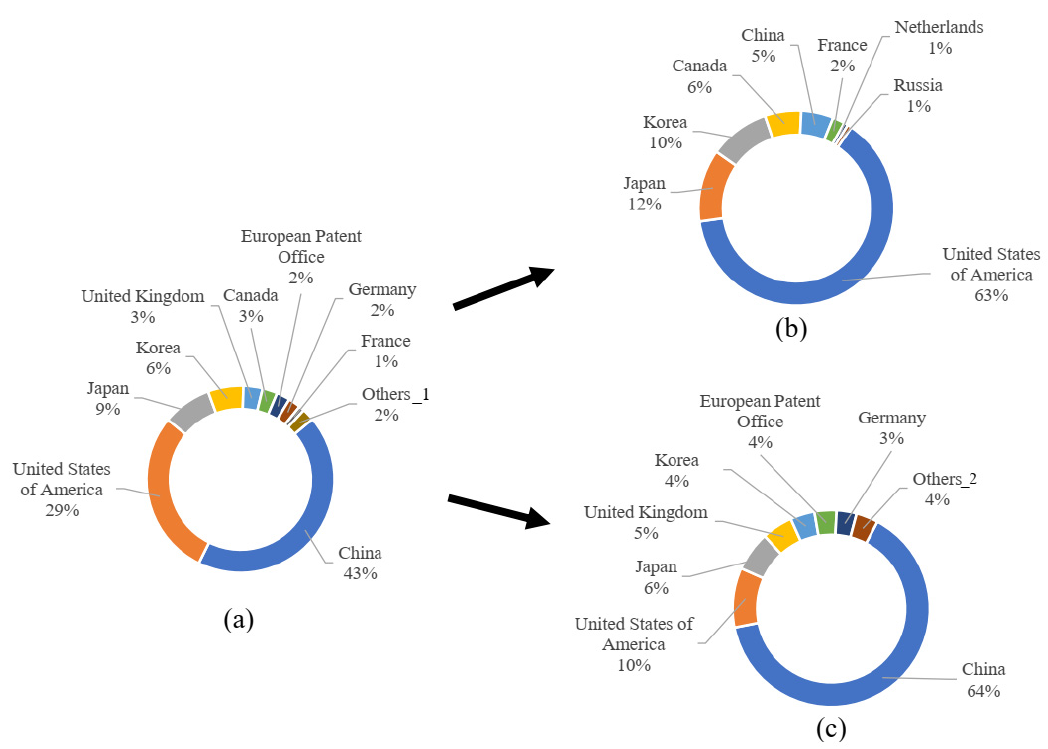
Figure 3. ( a ) Published patents based on countries, ( b ) Granted patents based on countries, and ( c ) Published but not yet granted patents based on countries, on ankle sprain prevention methods.